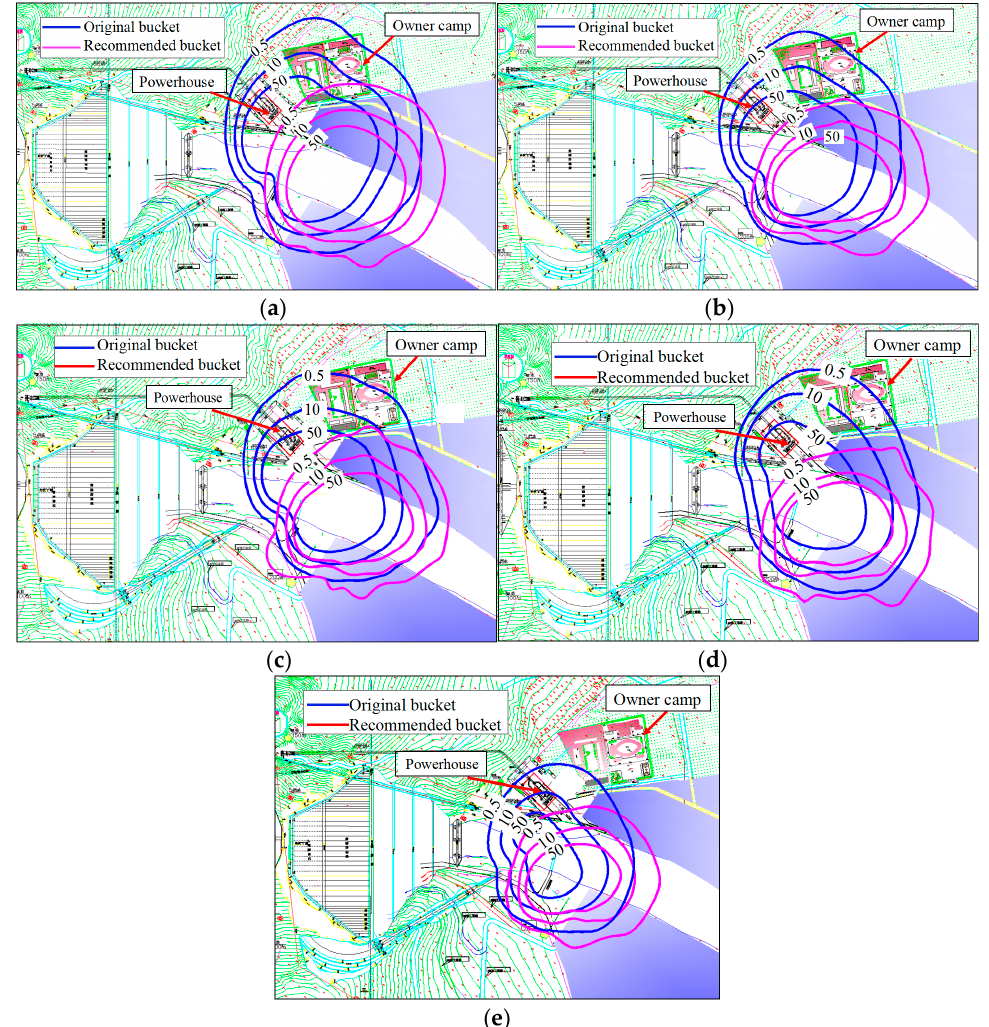
Figure 12. Rainfall intensity distribution of original and recommended buckets with different prototype conditions: ( a ) condition 1; ( b ) condition 2; ( c ) condition 4; ( d ) condition 5; ( e ) condition 7 (units: mm h − 1